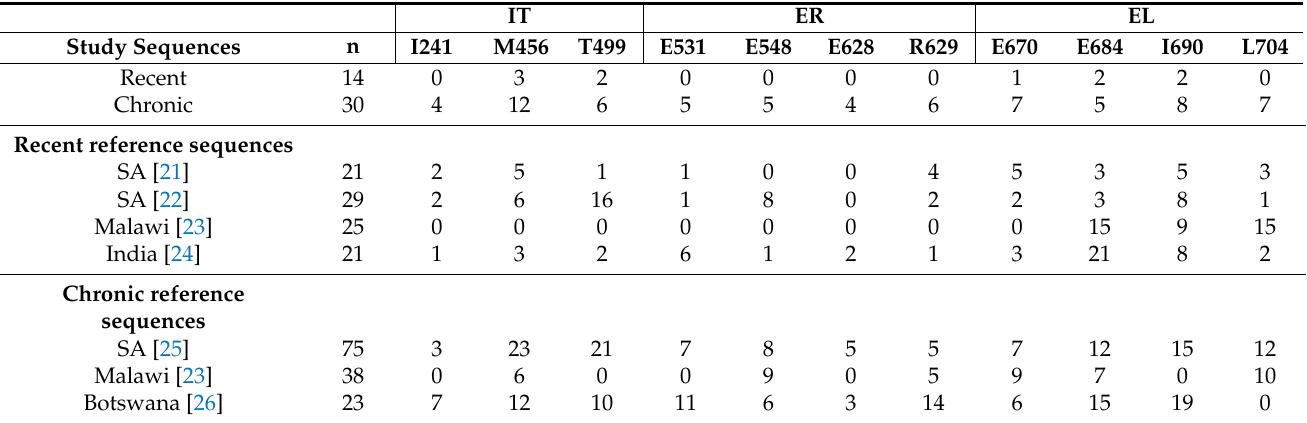
Table 3. Comparison of the frequency of highly informative amino acid mutations between study sequences and reference